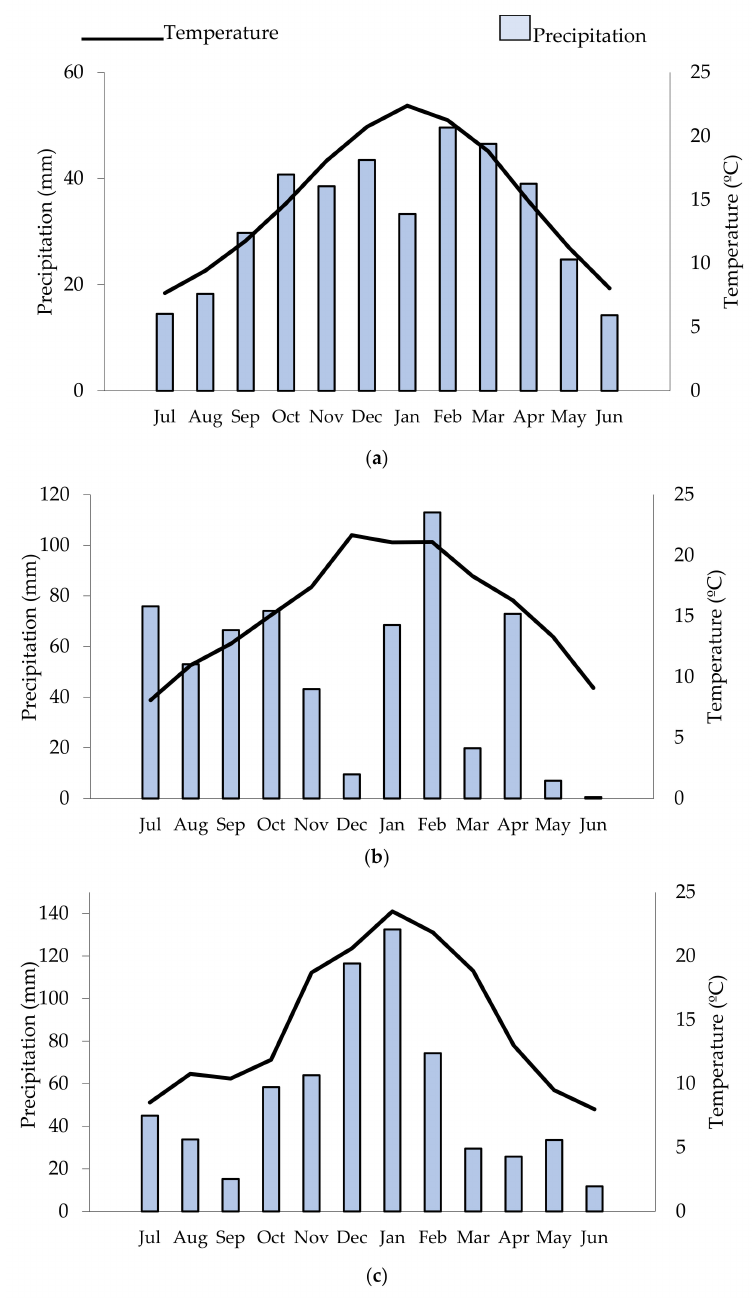
Figure 1. Ombrothermic diagrams: periods ( a ) 1966–2016, ( b ) 2014–2015 and ( c )